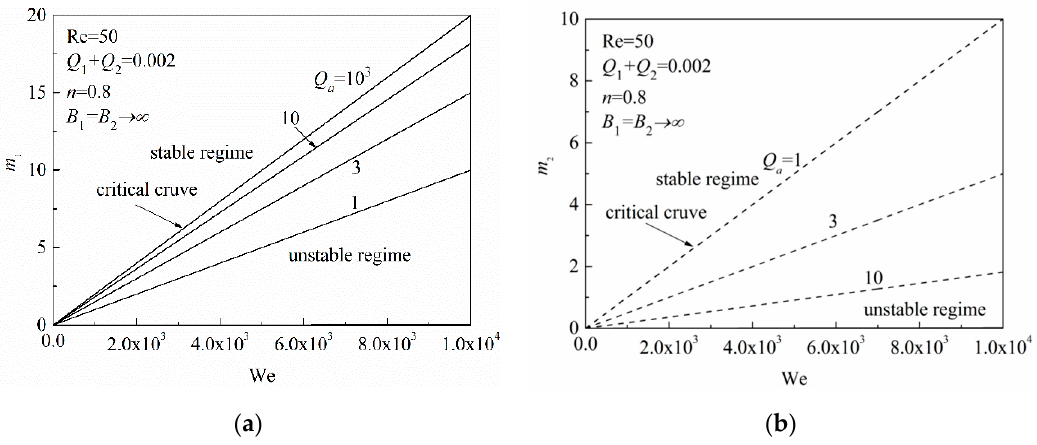
Figure 9. Effect of the aerodynamic asymmetry on the unstable range of power-law plane jets: ( a ) para-sinuous mode (solid line); ( b ) para-varicose mode (dash line).